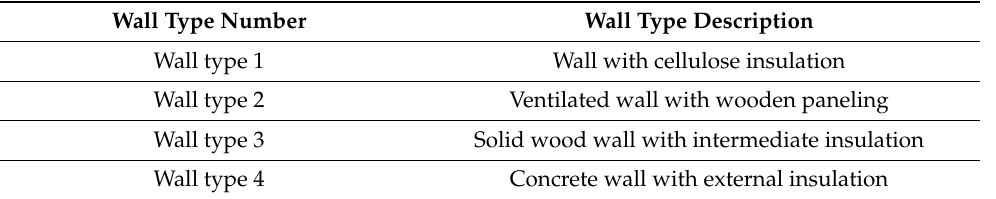
Figure 18. Heating energy demand and indoor room temperature for construction types with glazing equal to existing building (for wall type description see Table 4) [53]. Table 4. Wall type numbering and description for Figures 18 and 19 [53]. Table 4. Wall type numbering and description for Figures 18 and 19 [53].